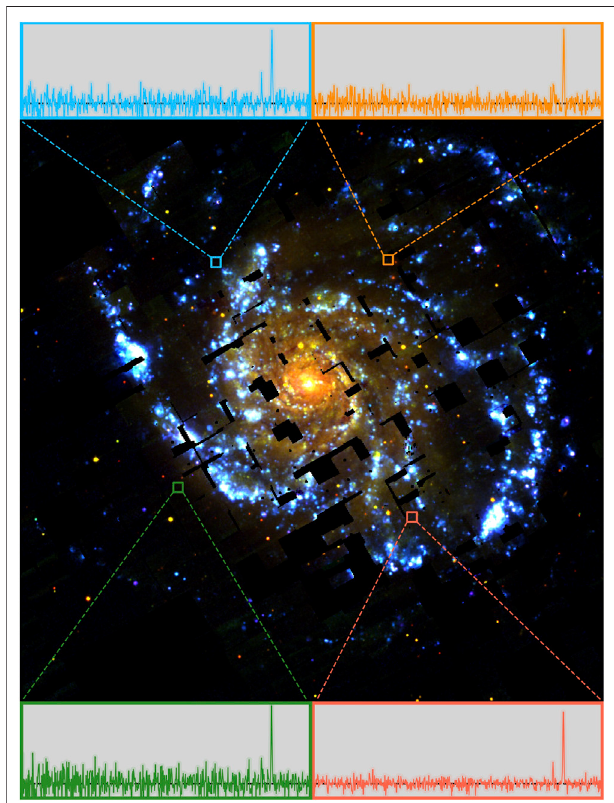
FIGURE6| An[OIII] λ 5007 “ image ” ofM101,asderivedfromVIRUSIFU observations during the HETDEX survey. The data represent 16 pointings at 18 min per pointing, and is 20 ′ on a side. The missing segments are due to IFUs that were malfunctioning or not installed at the time of the observations. The spectra of four PNe are